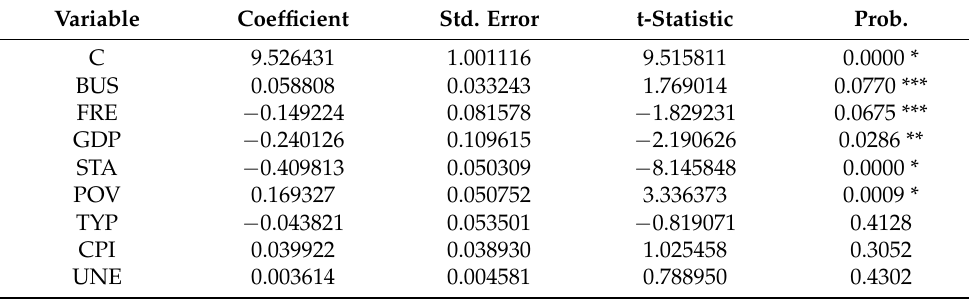
Table 9. Fixed effect model (FEM)—CS fixed + period fixed (dummy